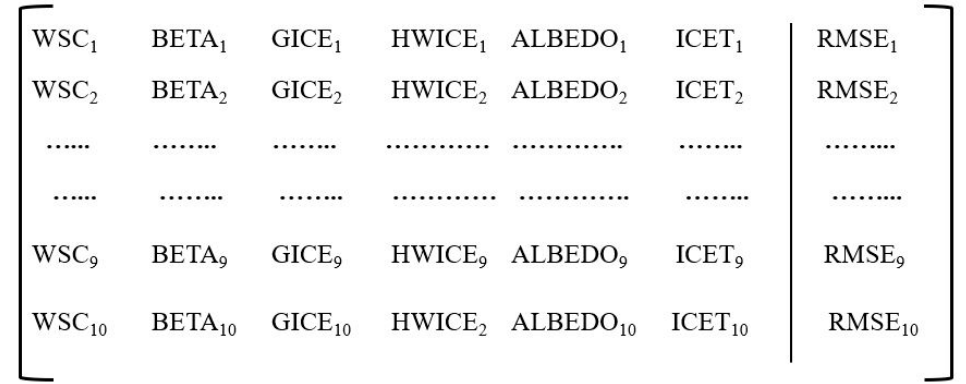
Figure 3. Scheme of the IGHS memory applied for calibration of CE-QUAL-W2 model. Each row in this schematic memory represents a solution which is composed of six CE-QUAL-W2 parameters and a corresponding RMSE value calculated by comparing model-simulated temperatures with observations.